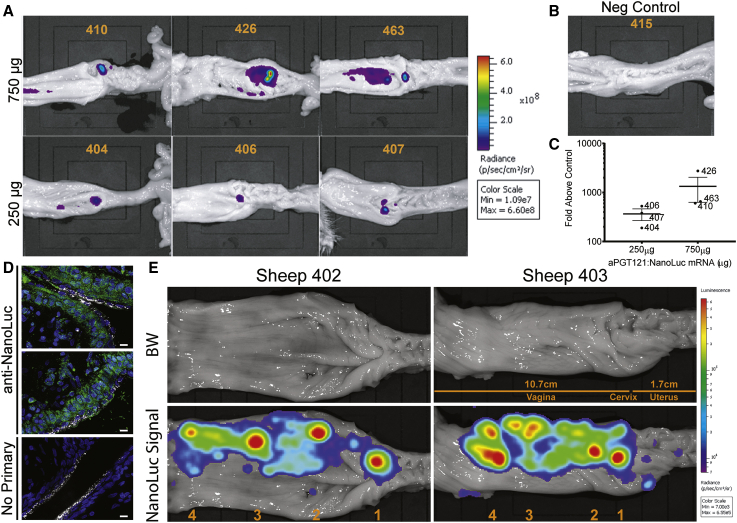
The Entire Sheep Cervicovaginal Epithelium Is Receptive to Transfection by Large Doses of aPGT121 mRNA(A) A single 250 μg or 750 μg dose of aPGT121-NanoLuc was delivered by aerosol to the cervix. After 24 h, sheep were euthanized, FRT excised, luciferin added, and luminescence measured via IVIS. Representative images demonstrating the intensity in each animal are displayed. (B) The FRT from an untreated sheep processed in the same manner as in (A). (C) The average radiance at the cervix over the average radiance in the control animal, for each mRNA dosing group. Error bars represent the ± 95% CI. (D) In 2 animals, aerosolized dye-labeled mRNA was delivered as previously described. After 24 h, the cervix was excised and processed for immunofluorescence tissue imaging. The bottom panel represents secondary only control. DAPI, cell nuclei; white, aPGT121 mRNA; green, anti-NanoLuc antibody. Section scale bars represent 10 μm. (E) aPGT121-NanoLuc mRNA was sprayed in four consecutive 750 μg doses, beginning at the cervix (marked as “1”) and retracting caudally to distal vagina (“4”).